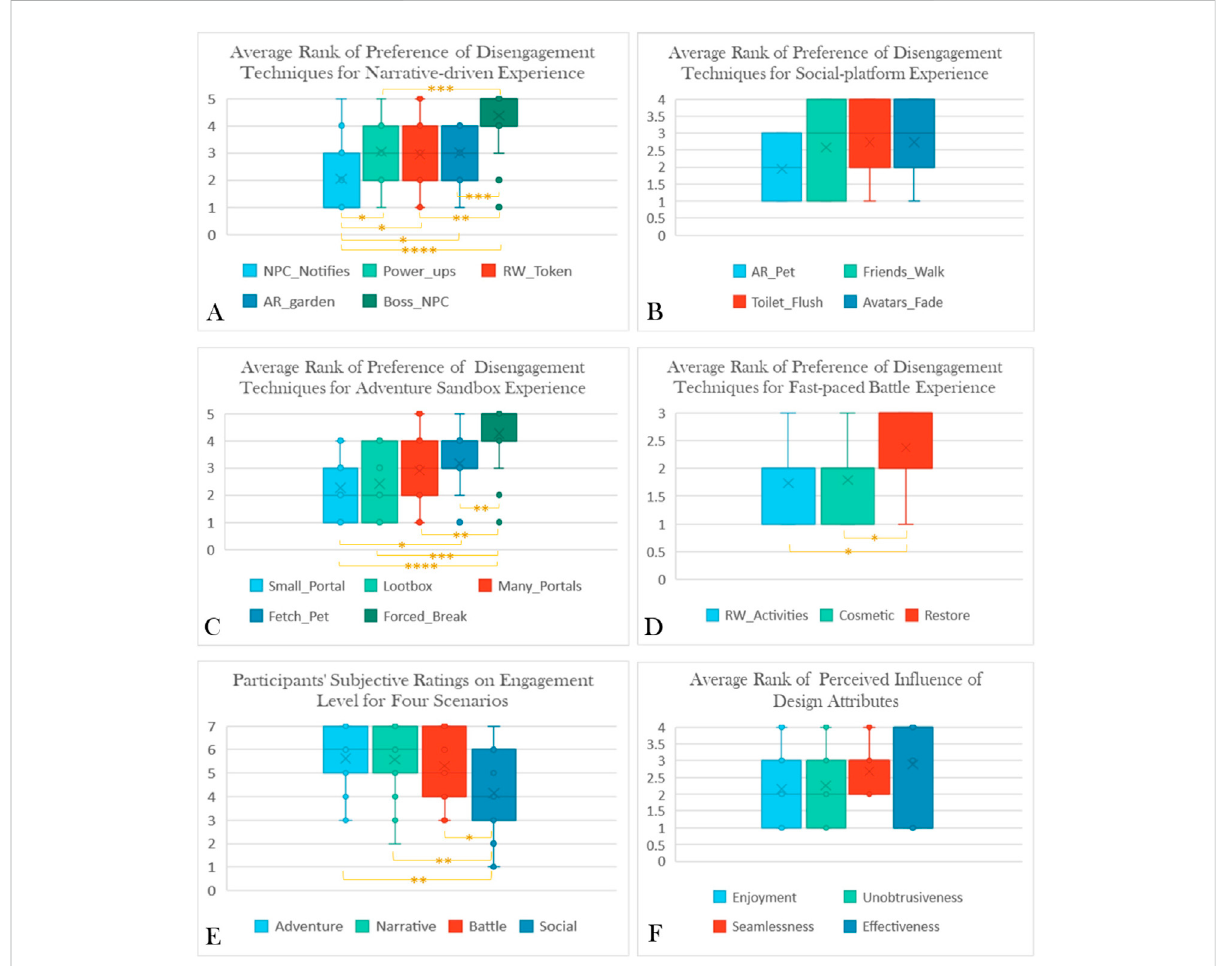
FIGURE 9 Plots for the results of Q1-Q6 with ranking [lower is better — (A – D,F) ] and rating data [higher is better — (E) ]: (A) Q1 — Average rank of preference ofdisengagement techniquesfor narrative-driven experience, (B) Q2 — Average rank for social-platform experience, (C) Q3 — Average rank for